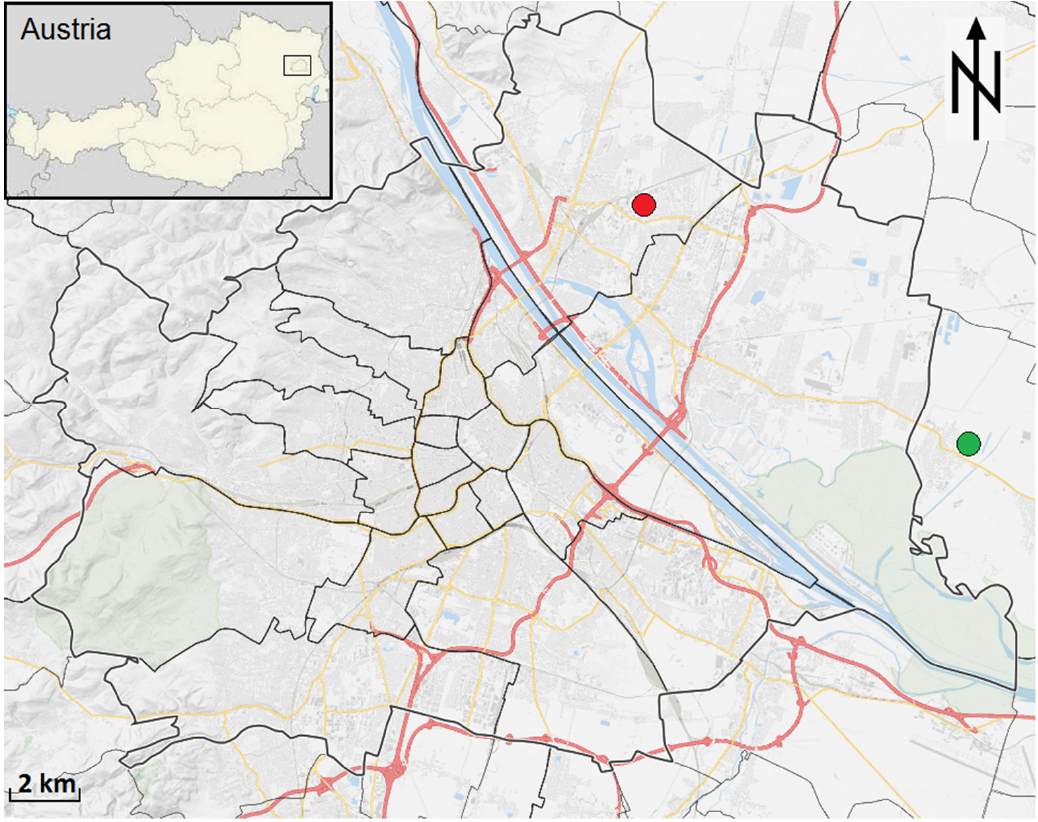
Figure 1. Map of Vienna (grey shading indicating topography, red and yellow lines for highways and main streets) with the location of the site ENERGYbase at the Viennese district Floridsdorf (red dot, see Figure 2 for details) and the next rural meteorological station Gross-Enzersdorf (green dot) (source: OpenStreetMap).